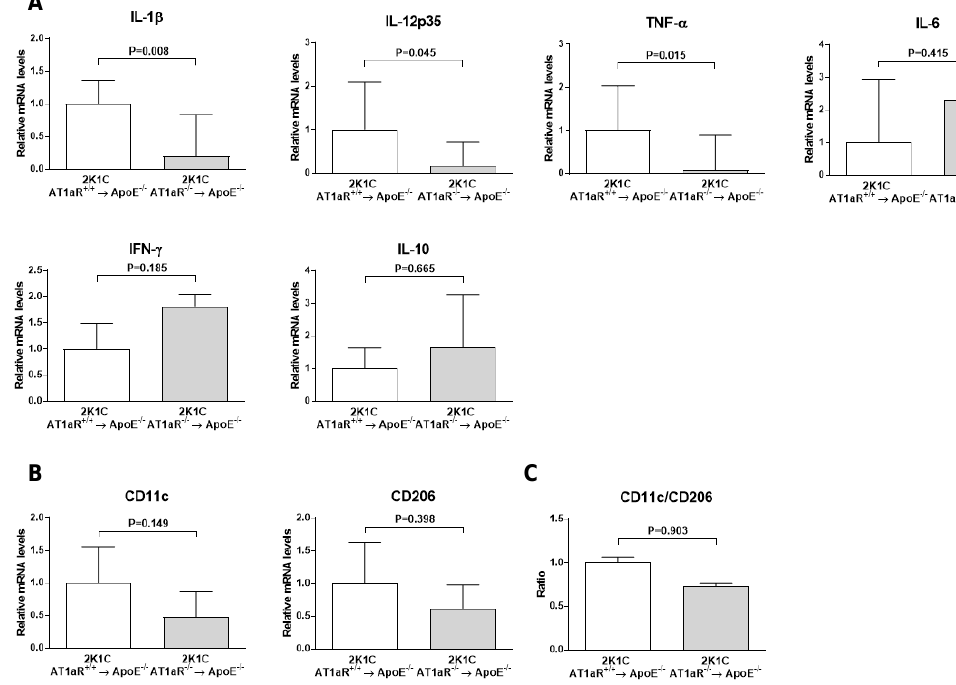
Figure 6. Effect of AT1aR deficiency in BM-derived cells on vascular expression of cytokines and macrophage phenotype markers. ( A ) mRNA levels of pro-inflammatory cytokines IL-1 β , IL12p35, TNF- α , IL-6 and IFN- γ as well as anti-inflammatory cytokine IL-10; ( B ) mRNA levels of M1-associated marker CD11c as well as M2-associated marker CD206. mRNA levels were determined in aortic tissue by real-time RT-PCR analysis. Data were normalized to 36B4 and expressed as fold change over controls which were set at 1. Error bars are the SEM of the ∆ CT values; ( C ) Quantification of CD11c to CD206 ratio (M1/M2 balance marker). n = 3 to 10 animals per group.